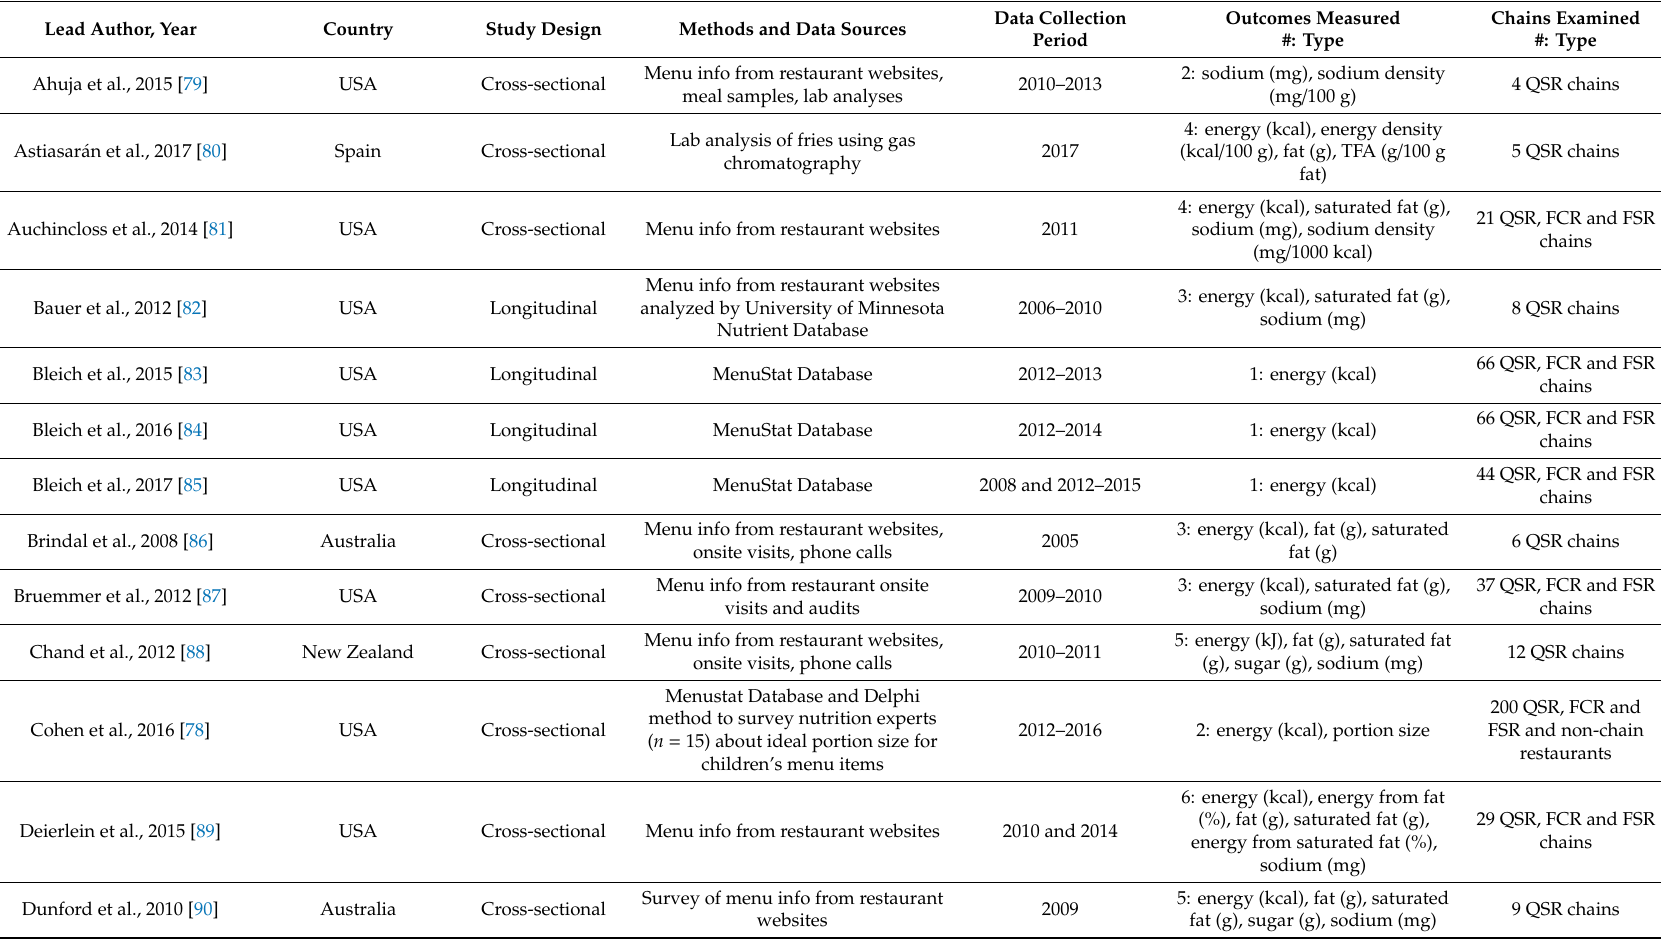
Table 5. Studies included in the systematic review summarized by country, study design, methods, data collection period, outcomes measured, and chains examined,